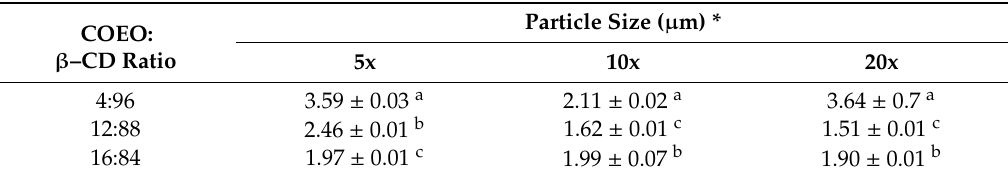
Table 3. Particle size ( µ m) values for each COEO: β –CD ratio.